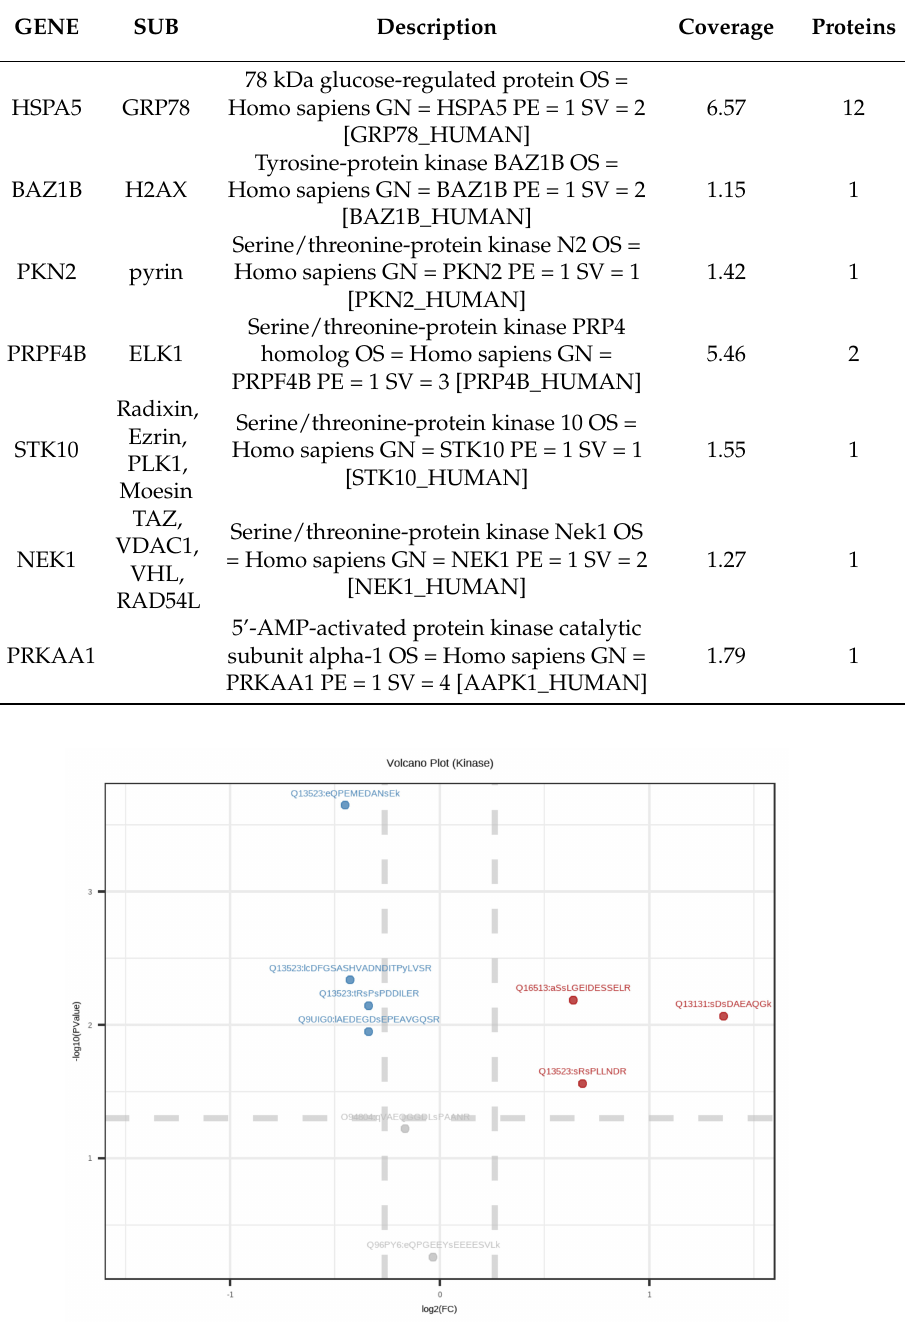
Figure 4. Kinases identified with